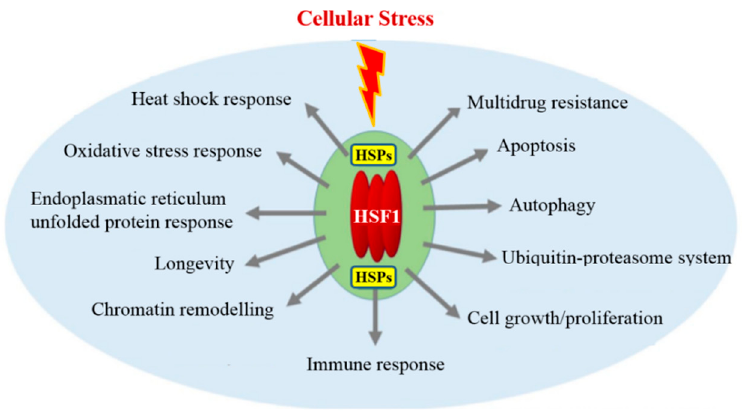
Figure 5. Heat shock factor 1 (HSF1) cellular stress response. HSF1 plays a central role in the upregulations of heat shock proteins (HSPs). HSF1 activity then upregulates vital components of diverse stress response pathways and processes.